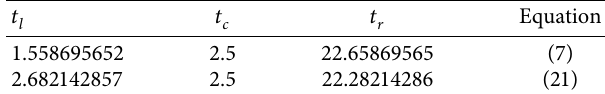
Figure 2: Te best generalized fuzzy quantity for w � 10, solid curve: u ; dashed curve: equation (7); dotted curve: equation Table 3: Results of Example 3.